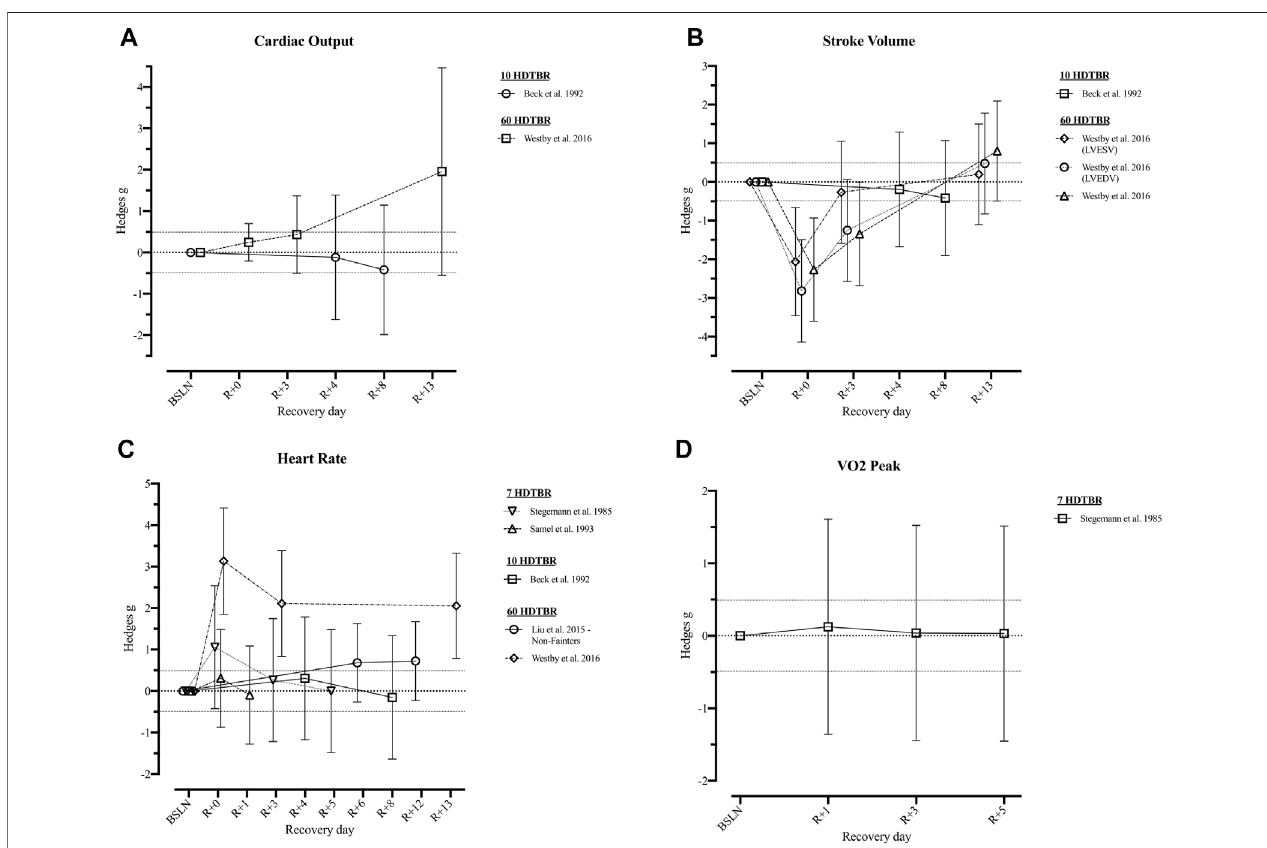
FIGURE4| Visualisationoftherecoveryofoutcomesrelatedtothe ‘ Cardiovascular System ’ (Part1)afteraperiod ofhead-down-tilt bedrest,displayed asHedges g with 95% Con fi dence Interval. (A) Recovery of the Cardiac Output at rest (B) Recovery of outcomes related to the Stroke Volume at rest (C) Recovery of the resting Heart Rate (D) Recovery of the VO2 peak. To determine whether a particular outcome could be deemed as “ recovered ” during the recorded recovery period, the Westlake ’ s Con fi dence Interval Procedure (Seaman and Serlin, 1998) was used. This procedure tests for equivalence between two means using a con fi dence interval.Todoso,Upper(0.49)andLower( − 0.49)equivalencyboundsofinterestweredetermined,correspondingtothelimitofasmalleffectsize.Whencombinedwith the95%Con fi denceIntervaloftheHedges g ,threescenariosarepossible:1) Noevidenceofrecovery :Itcannotbeconcludedthatthedifferencebetweenmeansistrivial as the 95% Con fi dence Interval falls completely outside the set equivalency bounds; 2) Weak evidence of recovery : The results are inconclusive as the 95% Con fi dence Interval partially falls within the set equivalency bounds, thus including both trivial and non-trivial differences. The dotted lines at 0.49 and − 0.49 represent the upper